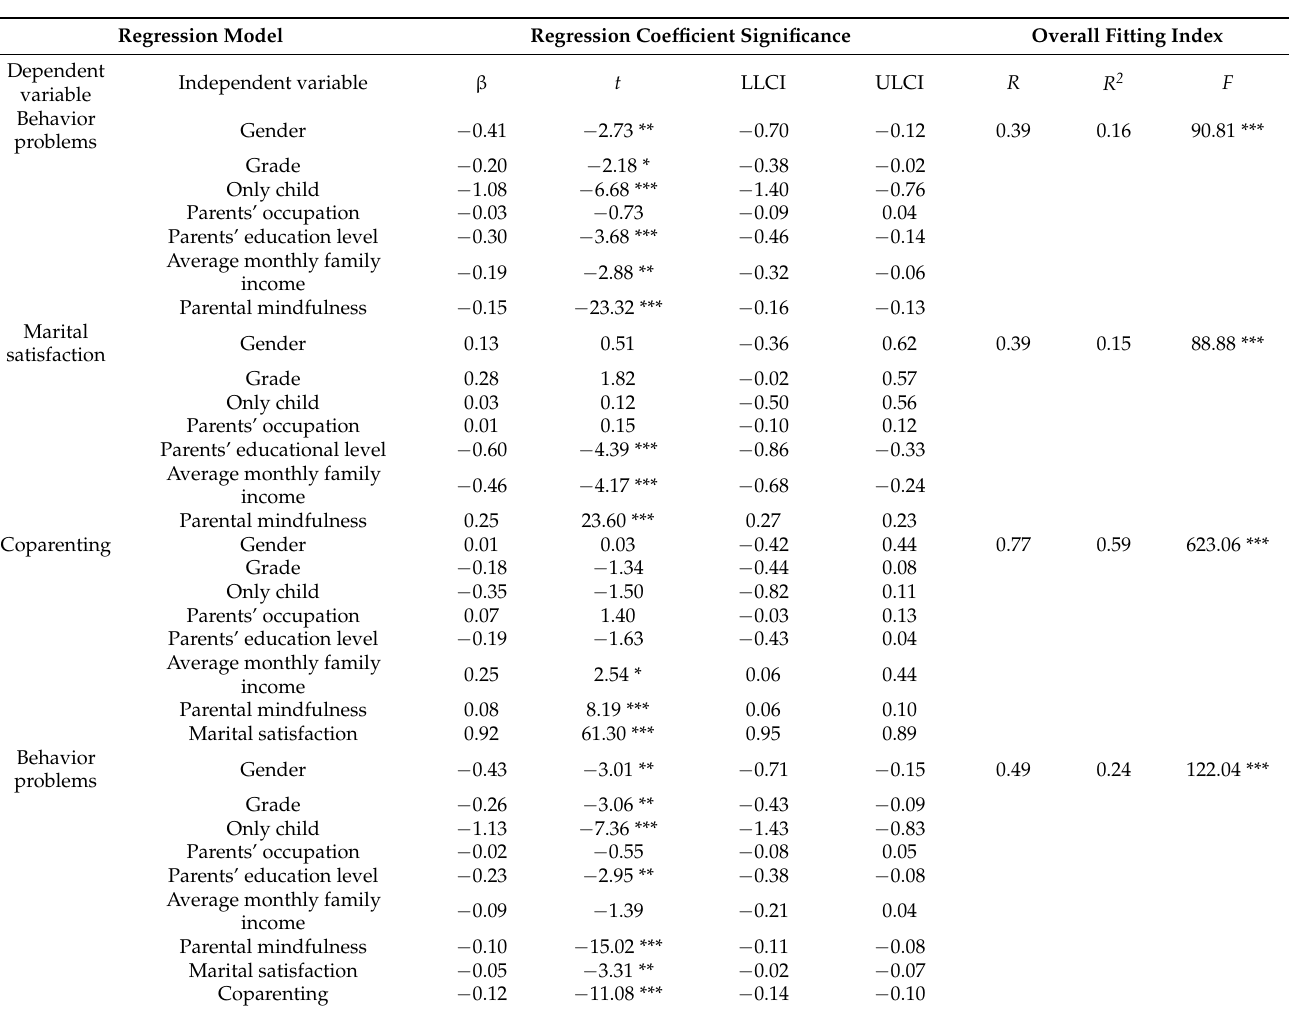
Table 3. Multiple regression